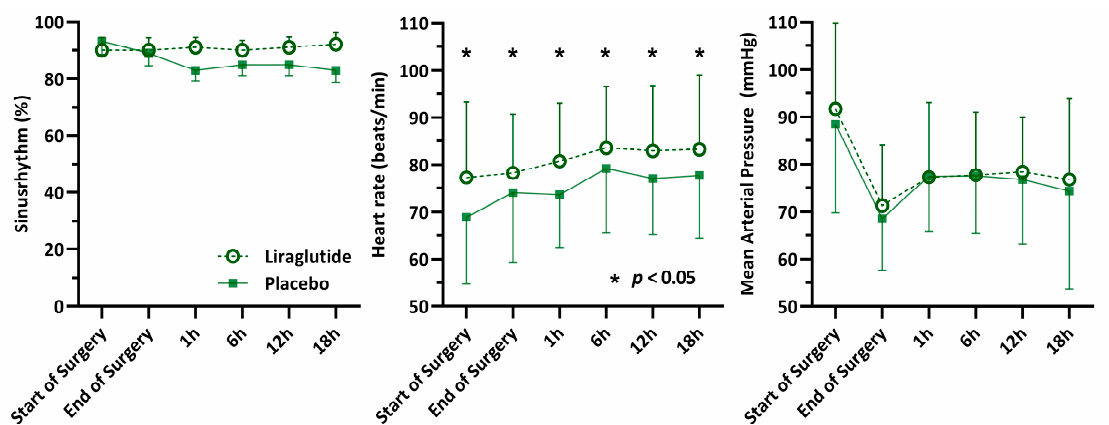
Figure 2. Perioperative haemodynamic measurements.